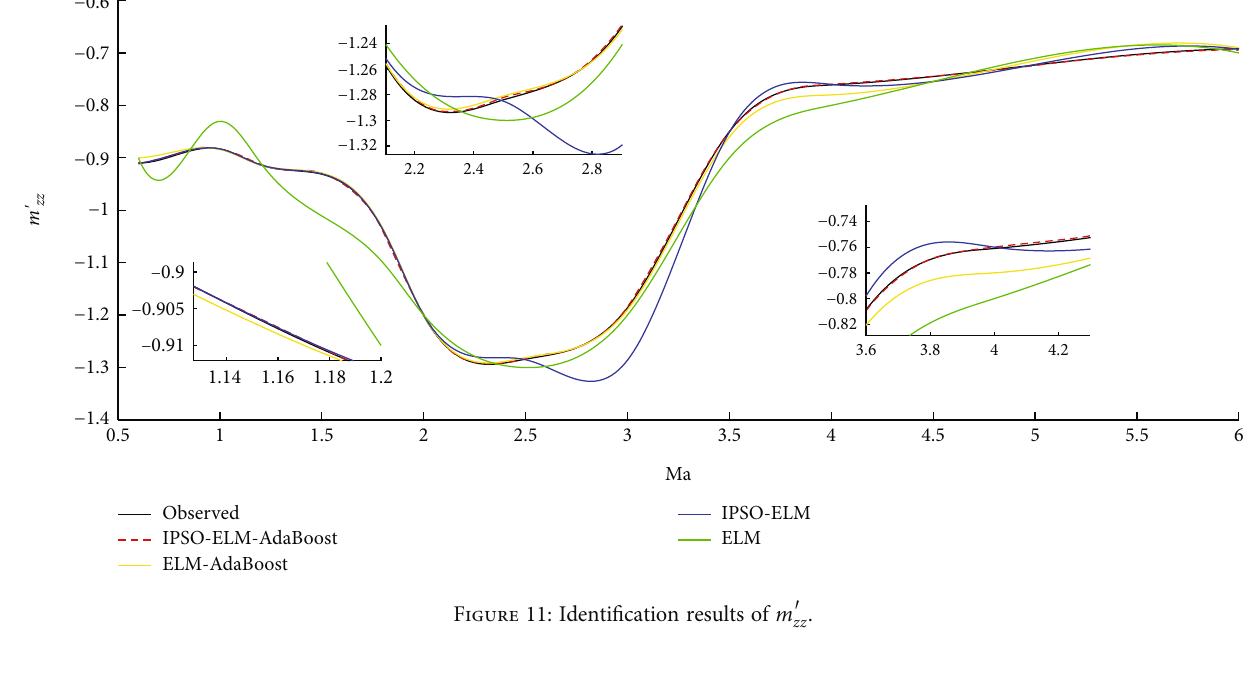
Figure 11: Identi fi cation results of m